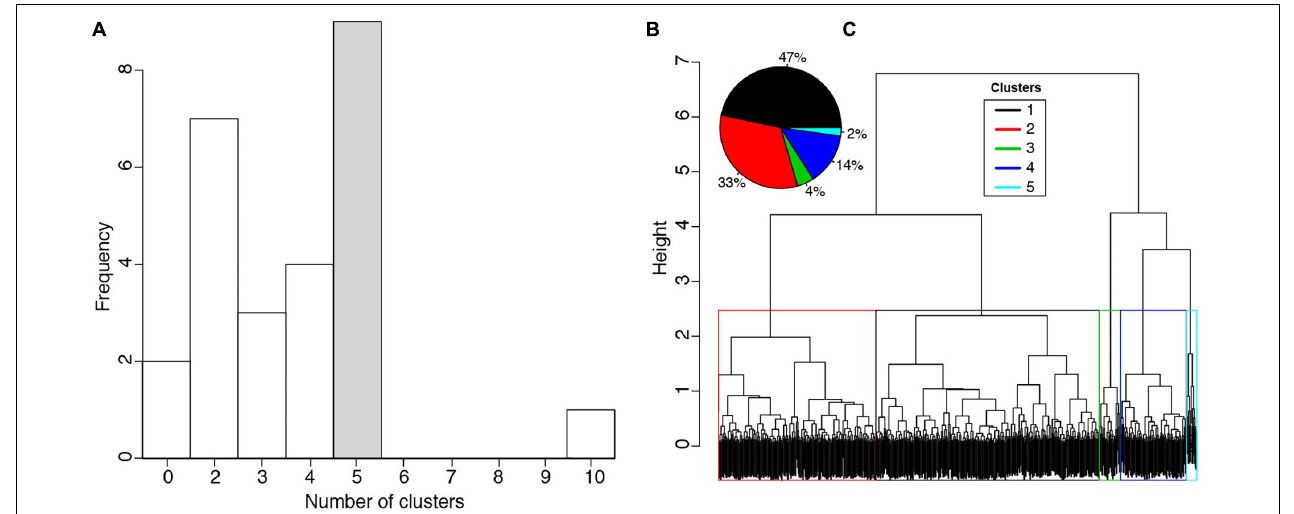
FIGURE 4 | Results of the hierarchical clustering analysis. (A) Frequency of clusters identified considering a total of 24 methods to estimate the number of clusters present in our cpx dataset. The majority of methods indicate that our dataset contains 5 compositional clusters. (B) Dendrogram obtained considering the Euclidean distance and the Ward method (Ward, 1963). The color boxes show the group of analyses associated with the respective cluster. The height represents the compositional difference required to merge clusters. The clusters are arranged horizontally so that the most different are at the two extremes of the dendrogram. (C) Pie chart showing the percentage of each of the five identified